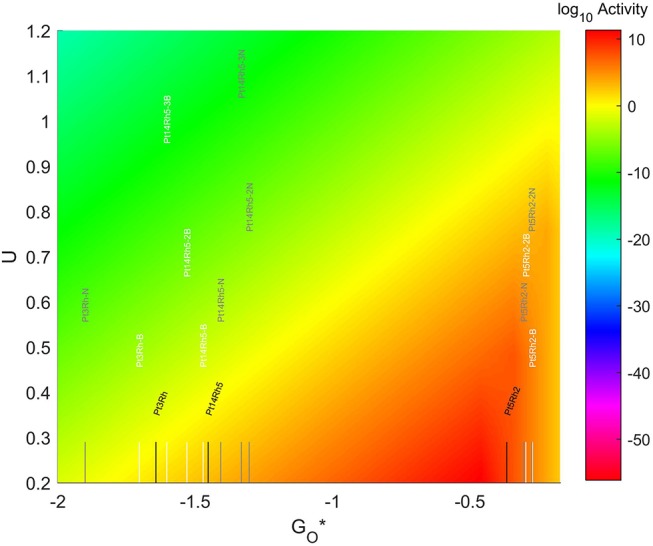
Volcano plot for ORR activity of Pt-Rh 4-atom, 7-atom, and 19-atom TMNP-doped-MDG. 4/7/19 atom systems are Pt3Rh1, Pt5Rh2, and Pt14Rh5, respectively.